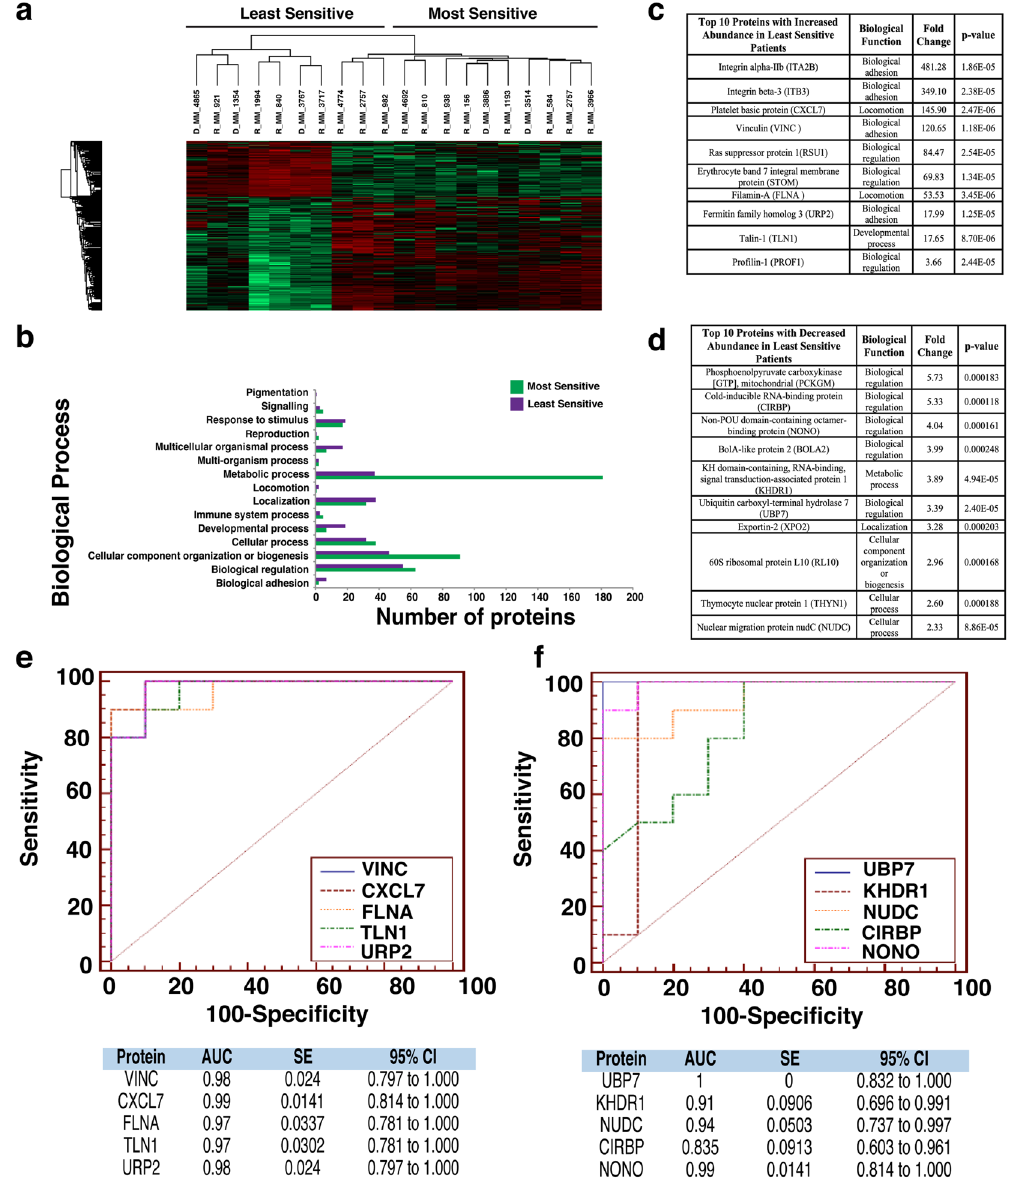
Figure 3. Proteomic analysis of patients following Quizinostat treatment. ( a ) Heatmap showing protein abundance changes of patients most and least sensitive to Quizinostat. Red indicates an increase in protein abundance, while green a decrease in protein abundance. ( b ) Graph showing the biological processes associated with the most and least sensitive patients. ( c ) List of the top ten proteins with increased abundance in the least sensitive patients. The associated biological function, fold change and p-value are also shown. Proteins were designated by p-value and arranged hierarchically by fold change. ( d ) List of the top ten proteins with decreased abundance in the least sensitive patients. The associated biological function, fold change and p-value are also shown. Proteins were designated by p-value and arranged hierarchically by fold change. ( e ) ROC analysis for the top five statistically significant proteins with an increased abundance for the least sensitive patients to Quizinostat, including the calculated AUC, standard error (SE) and 95% confidence interval (CI). ( f ) ROC analysis for the top five statistically significant proteins with a decreased abundance for the least sensitive patients to Quizinostat, including the calculated AUC, standard error (SE) and 95% confidence interval